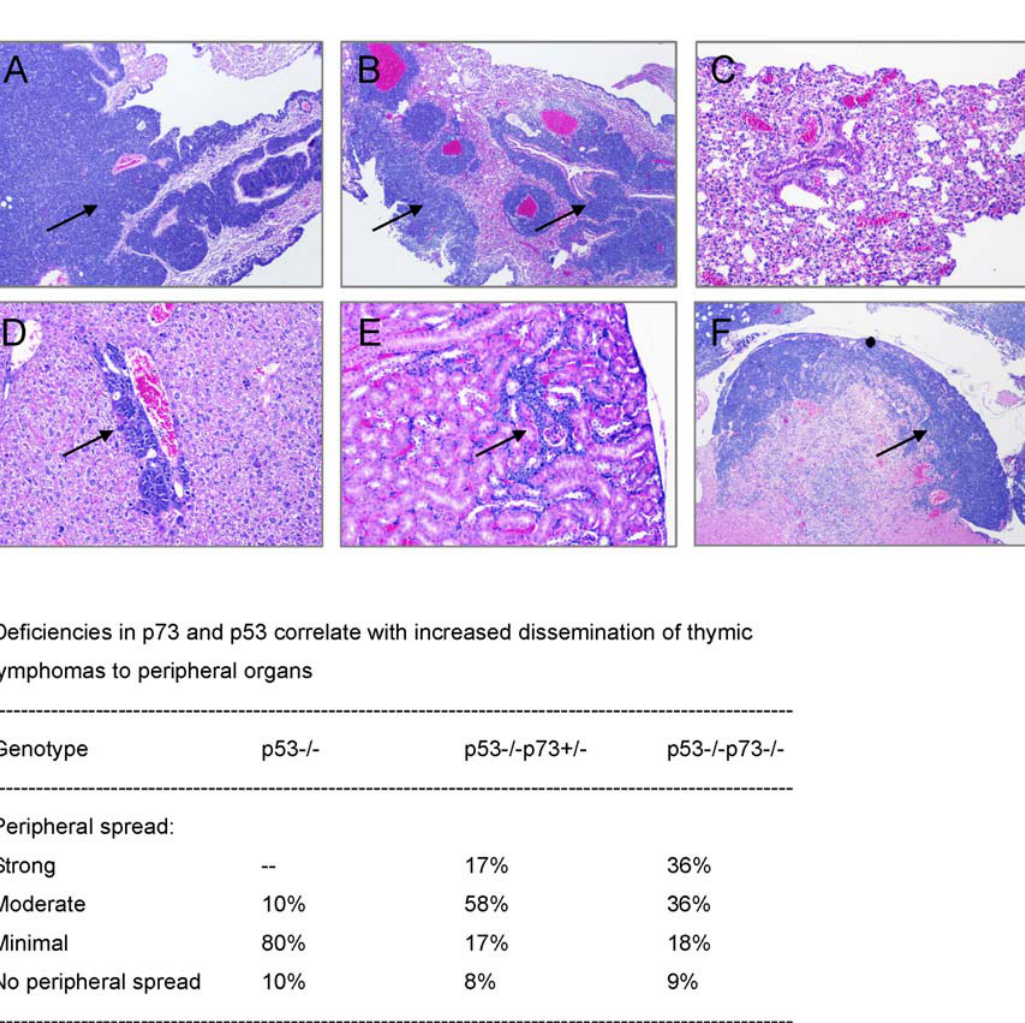
Figure 2. Loss of p73 enhances dissemination of lymphoma to peripheral organs. Hematoxylin and eosin staining of tissues from tumor- bearing p53 2 / 2 p73 2 / 2 mice showing lymphatic accumulation in lungs ( A, B ), liver ( D ), kidney ( E ), and heart ( F ). Lung section of a lymphoma- bearing p53 2 / 2 mouse is shown for comparison ( C ). Magnification 4X. The table lists the numbers of thymic lymphomas from mice with the indicated genotypes that either exhibited or lacked clear indications of invasion of peripheral organs by